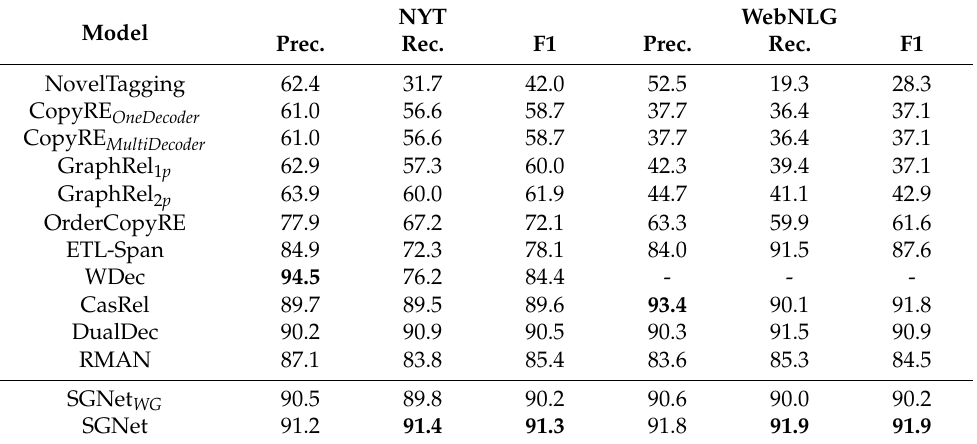
Table 2. Main results. Bold marks the highest score. SGNet WG does not contain graph